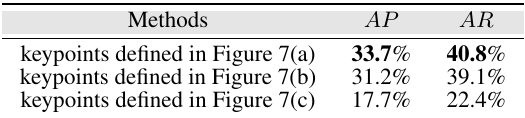
Table 2. The performance of the keypoint extraction results on Dataset A using different keypoint defintions and keypoint learning